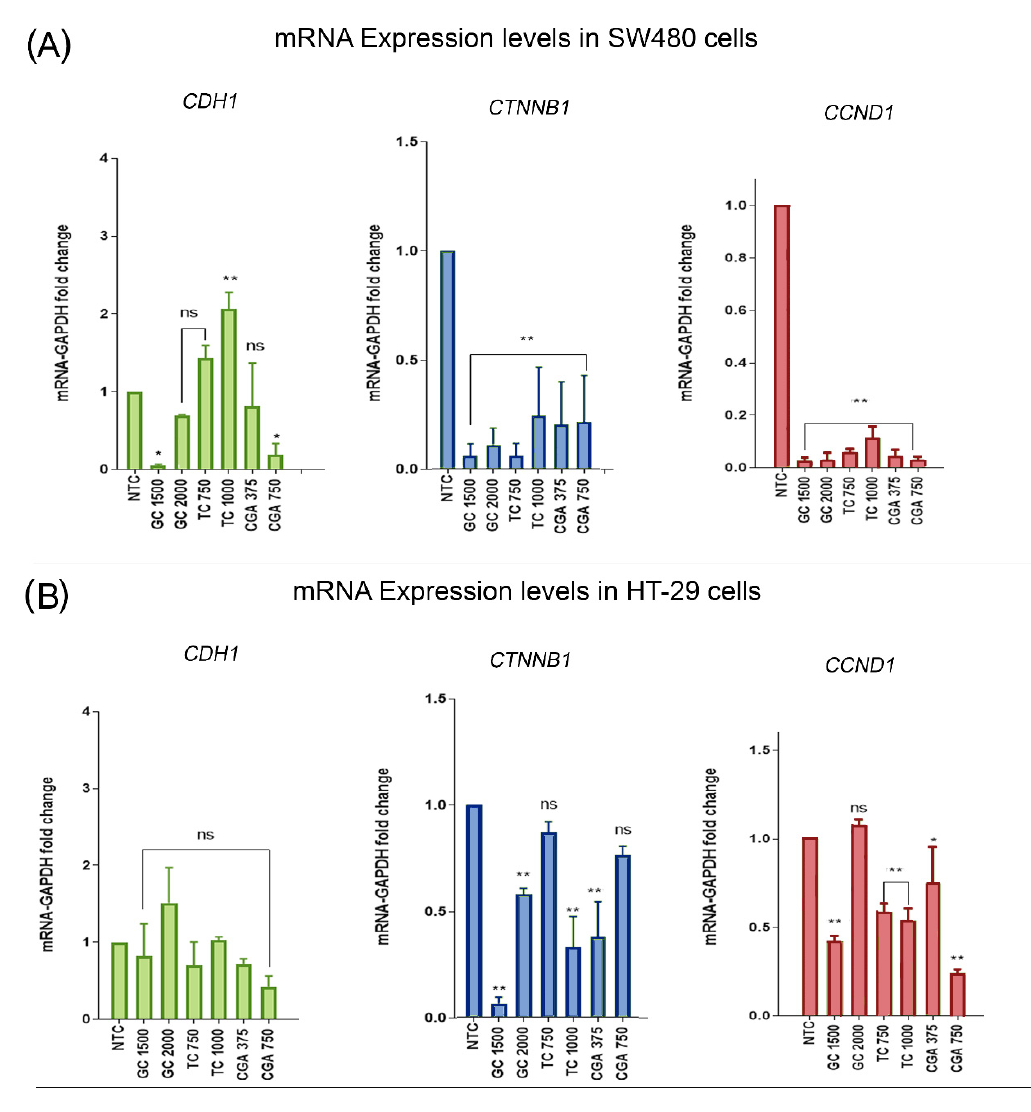
Figure 6. (CGA) Chlorogenic acid, (TC) toasted coffee extract, and (GC) green coffee extract modulation of the mRNA expression levels of CDH1, in green bars (which encodes for E-cadherin); CTNNB1 , in blue bars (which encodes for β -catenin); and CCND1 , in red bars (which encodes for Cyclin D1) in SW480 ( A ) and HT-29 ( B ) cell lines. Values are expressed as the mean ± SEM of three independent experiments. Two-way ANOVA, difference to non-treated cells, * p ≤ 0.05 and ** p ≤ 0.01. ns: non-significant differences.